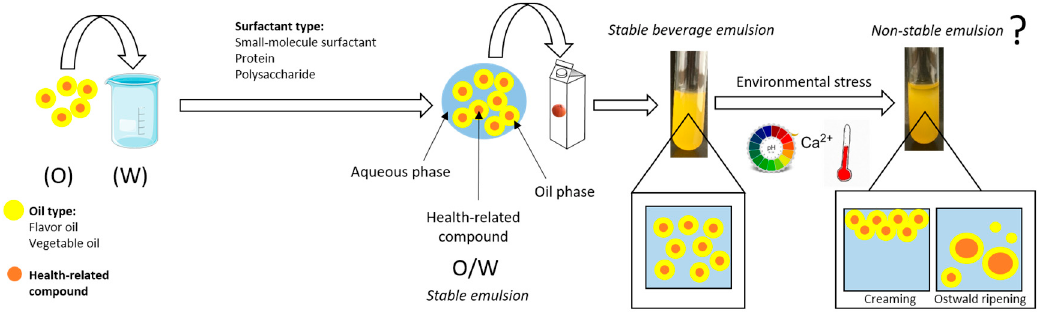
Figure 1. Scheme of beverage fortification with oil-in-water emulsions and their colloidal stability during manufacturing and storage.